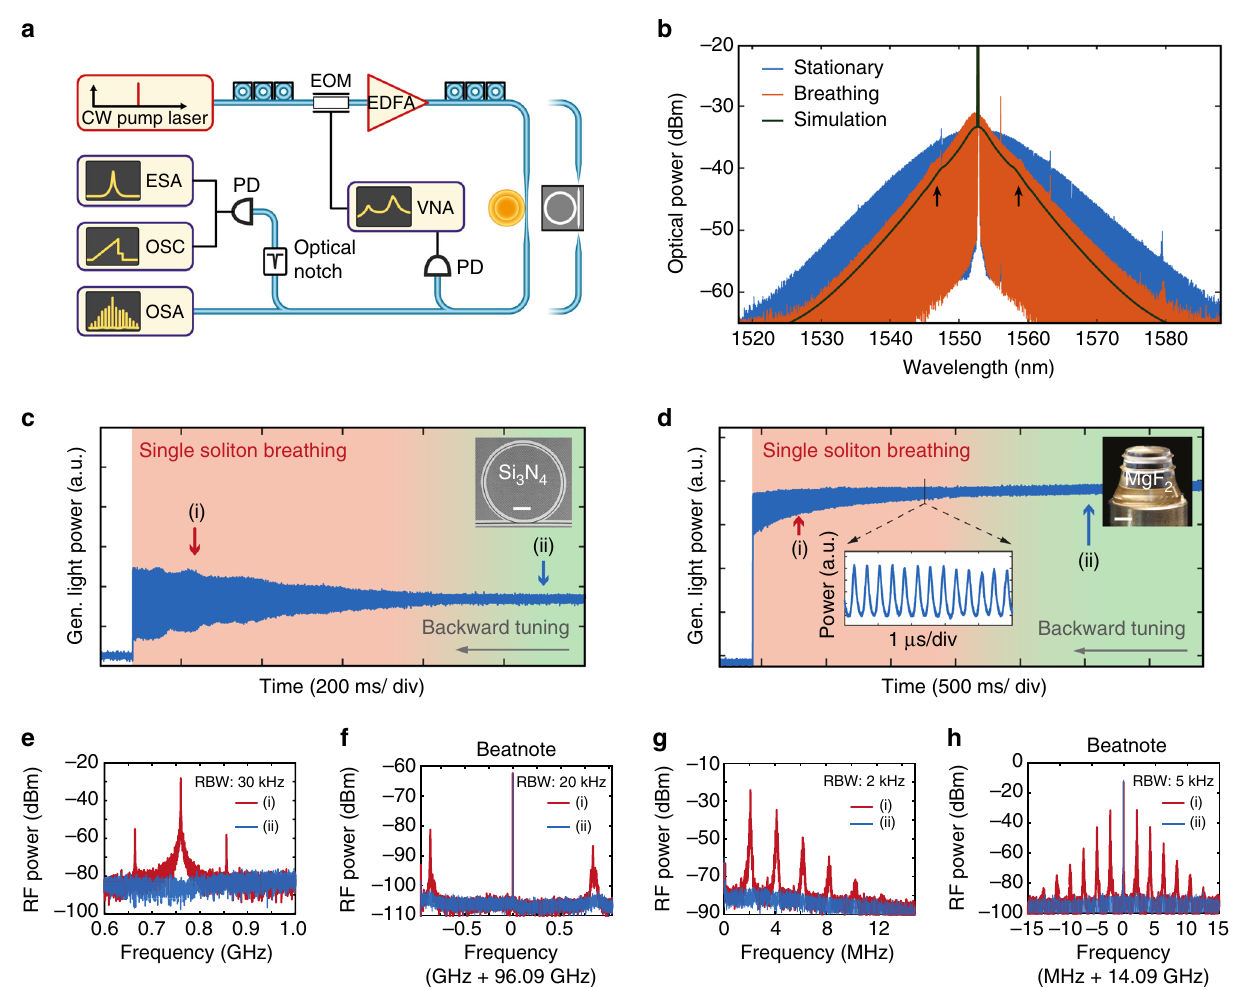
Fig. 2 Experimental observation of breathing solitons in Si 3 N 4 and MgF 2 platforms. a A similar experimental set-up is used for both platforms: A tunable continuous wave laser is used as a pump source. EDFA, erbium-doped fi bre ampli fi er; EOM, electro-optical phase modulator; OSA, optical spectrum analyser; PD, photodiode; OSC, oscilloscope; ESA, electronic spectrum analyser; VNA, vector network analyser. b Experimental optical spectra of a stationary ( blue ) and breathing soliton states ( red ), in the 14 GHz FSR MgF 2 crystalline resonator. The effective detuning δ is varied by 0.5 MHz between the two states. The simulated optical spectrum averaged over one breathing period ( black line ) was offset by 3 dB for better visibility. The arrows mark the positions of weak sidebands visible in both the simulated and measured spectra. c Generated light power evolution for a single-soliton state in the 100 GHz Si 3 N 4 microresonator as the pump is tuned backward, showing the transition from stationary state ( green shading ) to breathing ( red shading ) and fi nal decay. The inset shows an SEM image of the microresonator used (the scale bar corresponds to 100 μ m). d In the MgF 2 crystalline resonator (see inset, the scale bar corresponds to 2 mm), the comb light evolution features a similar behaviour as in d , when tuning backward. The inset shows the oscillations of the generated comb power, resolved with a fast photodiode and high sampling rate. e , f RF spectra of the generated light for a breathing (point (i) in c , d , red trace ) and stationary (point (ii) in c , d , blue trace ) soliton state respectively in the Si 3 N 4 and MgF 2 resonators. In f , the 0.4 GHz span is centred at 0.8 GHz, close to the fundamental breathing frequency. The resolution bandwidth (RBW) is indicated on the corresponding panel. g , h Repetition rate beatnote for a breathing (i, red ) and stationary (ii, blue ) soliton state in the Si 3 N 4 and MgF 2